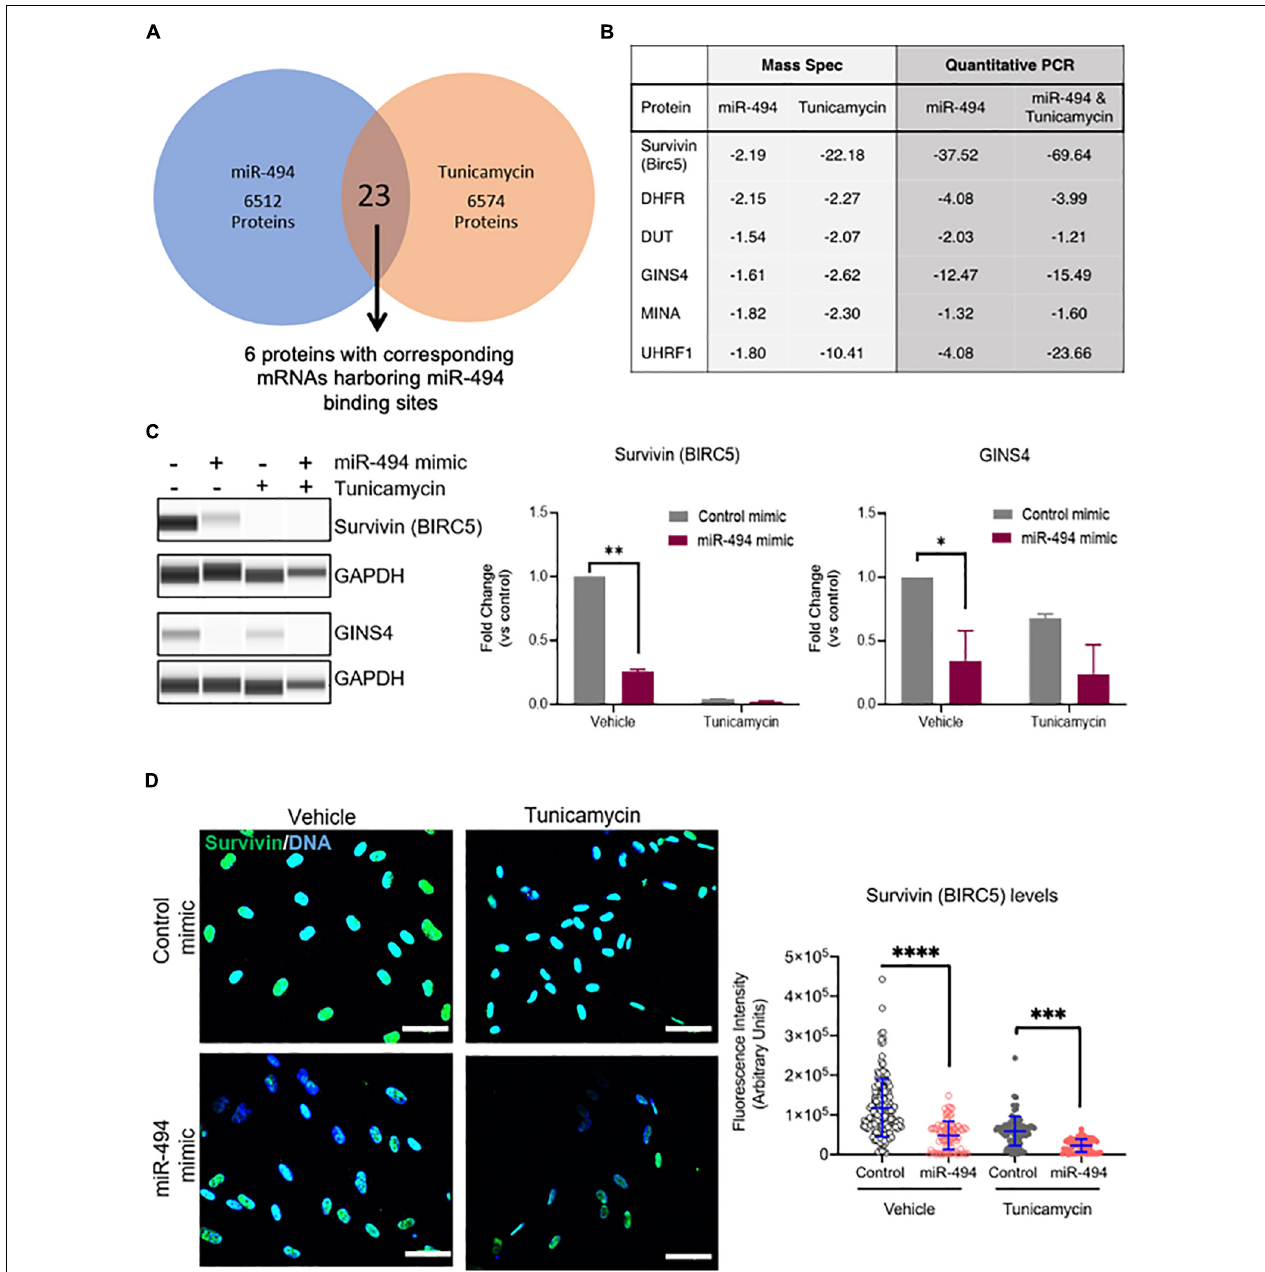
FIGURE 3 | miR-494 regulates target genes in cell survival and DNA replication. (A) Venn diagram showing the number of downregulated target proteins in a Tandem Mass Tag labeled Mass Spectrometry profile from HUVECs treated with TCN or transfected with miR-494 compared to vehicle treatment or control miR respectively. (B) Fold-change (compared to respective controls) of protein or mRNA levels as assessed by Mass Spectrometry or qRT-PCR respectively for the six targets that were downregulated in both TCN and miR-494 groups. All six targets harbor miR-494 binding sites in their 3 (cid:48) UTRs. (C) Representative Simple Western blot showing survivin ( BIRC5 ) and GINS4 levels in HUVECs 24 h after miR-494 transfection followed by TCN treatment (24 h). Right panels show quantitation of biological replicates. ∗ P < 0.05, ∗∗ P < 0.01, by two-tailed Student’s T -test. (D) Immunofluorescence images showing survivin expression in HUVECs 24 h after miR transfection and/or TCN treatment. Right panel shows quantification via ImageJ of survivin fluorescence intensity in each cell. Each dot represents individual cells. Scale bar in white = 50 µ m. ∗ P < 0.05, ∗∗ P < 0.01, ∗∗∗ P < 0.001 by one-way ANOVA with post hoc Tukey’s